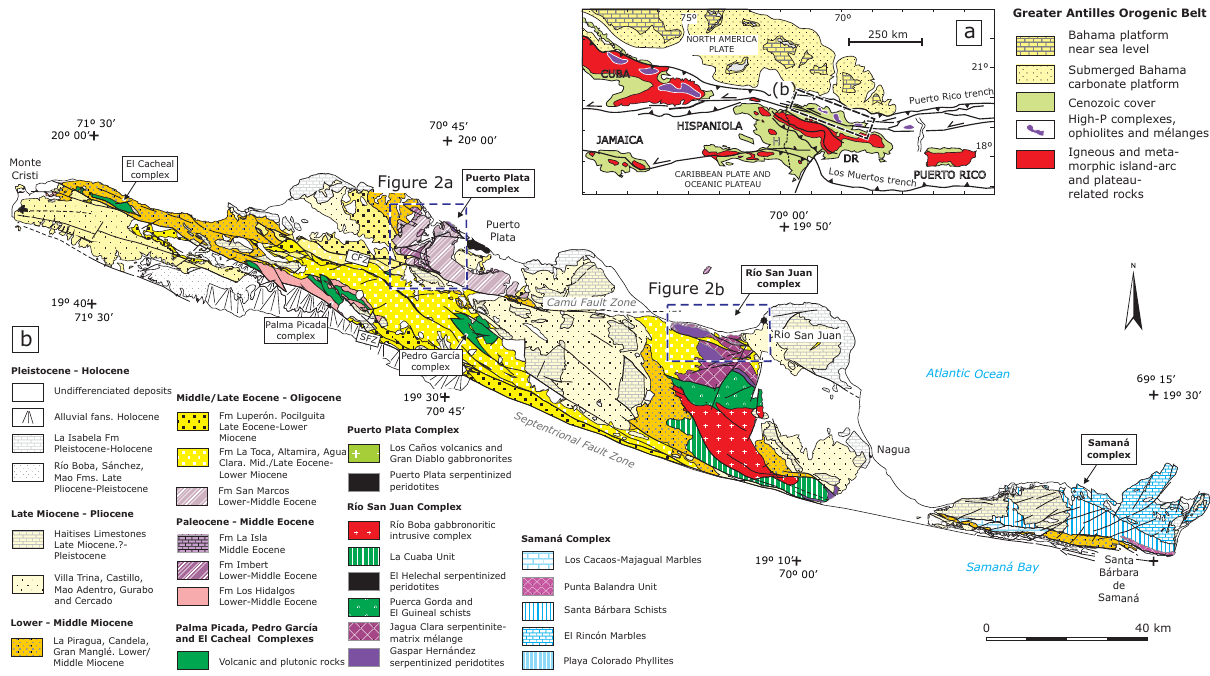
Figure 1. (a) Map of the northeastern Caribbean plate margin. Box shows location of the northern Hispaniola area. DR; Dominican Repub- lic, H; Haiti. (b) Geological map of Septentrional Cordillera and Samaná Peninsula modified from Draper and Lewis (1991), Draper and Nagle (1991) and Escuder-Viruete